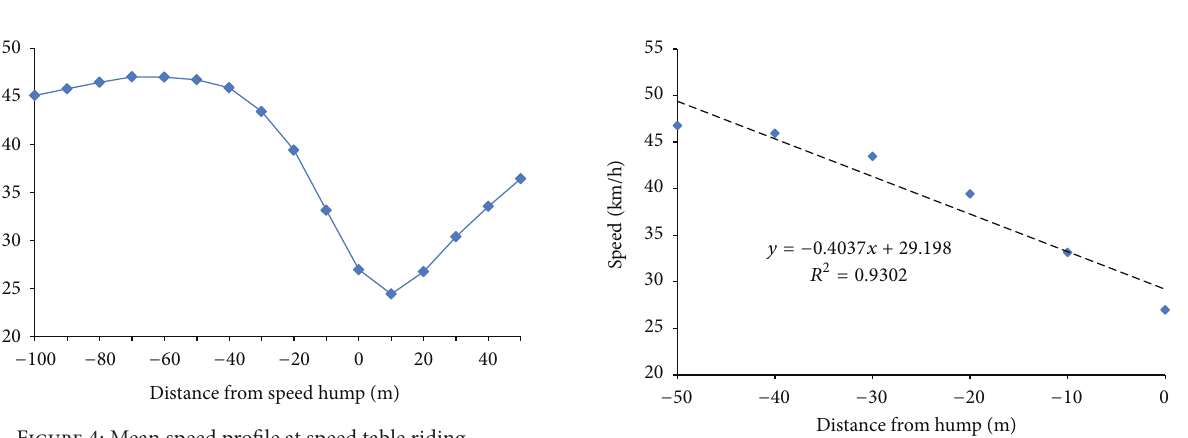
Figure 5: Scatter plots of speed versus distance from speed